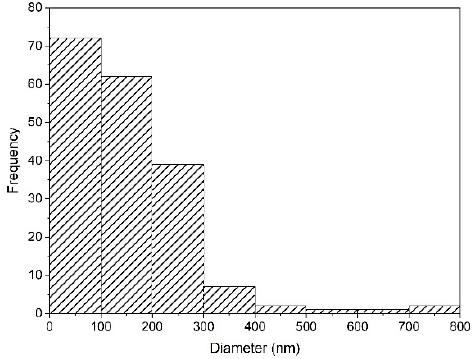
Figure 7. Particle size distribution of silica synthesized after precipitation with HCl at pH 2 in SEM-EDS using ImageJ.